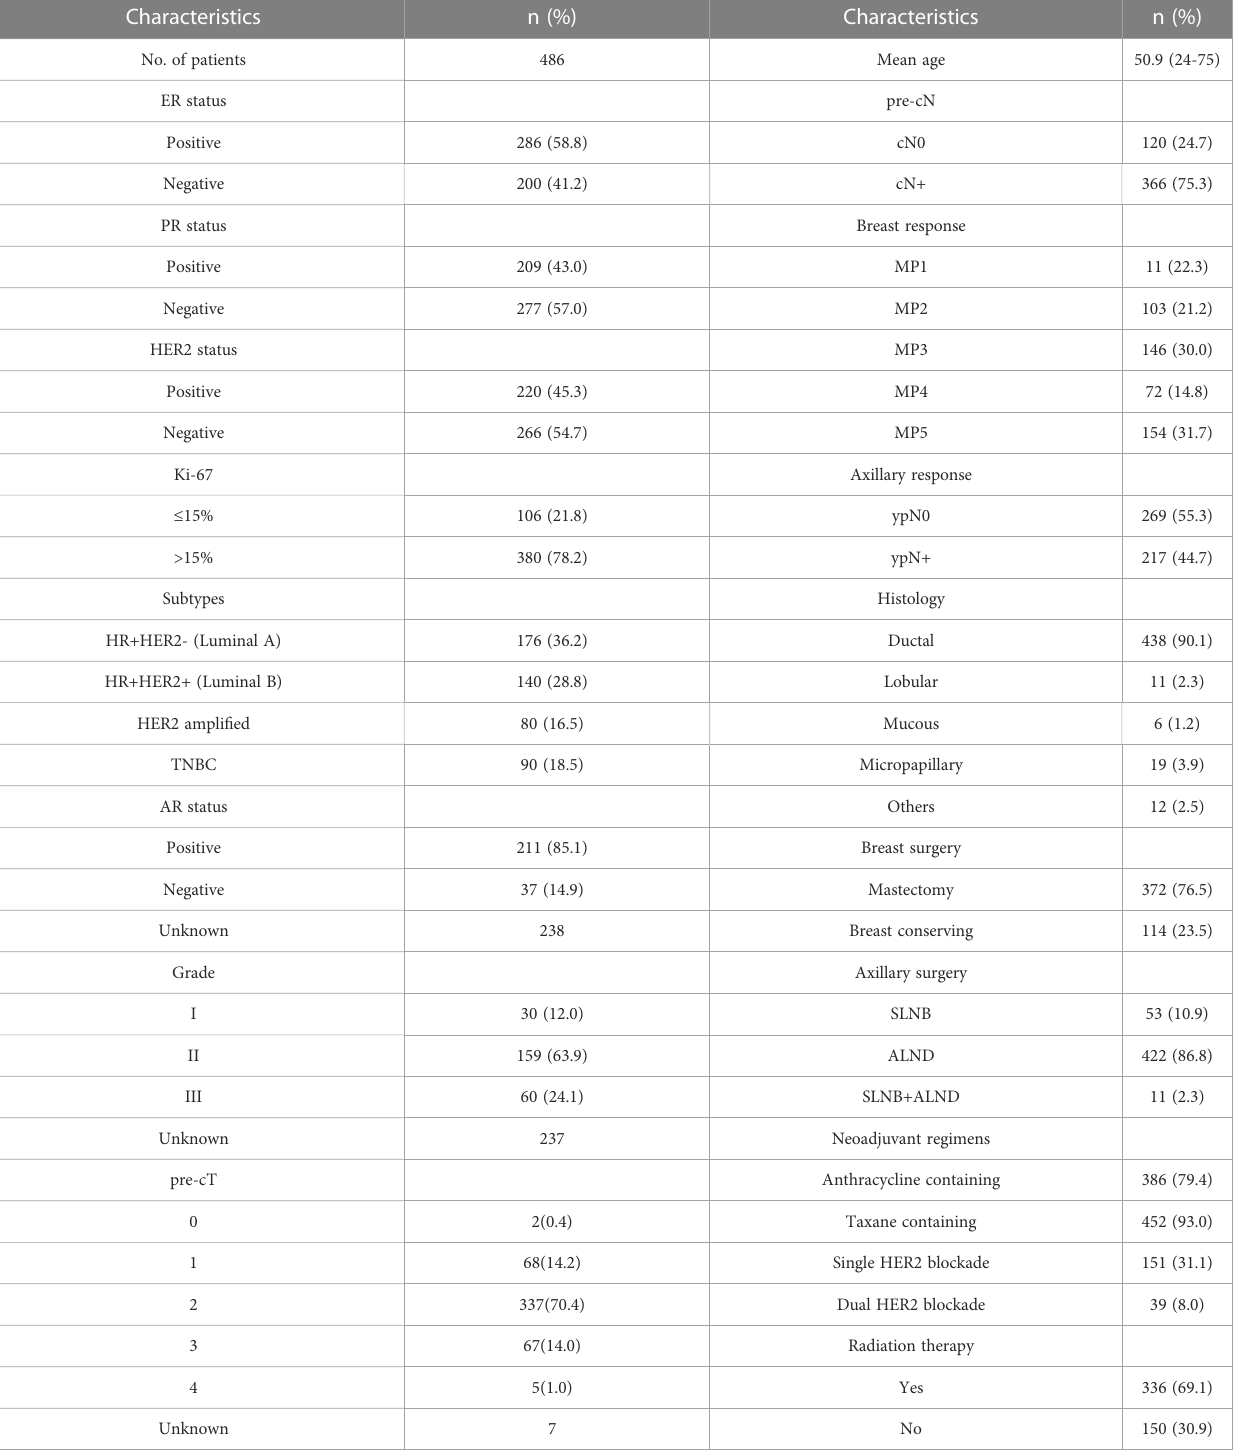
TABLE 1 Baseline characteristics of